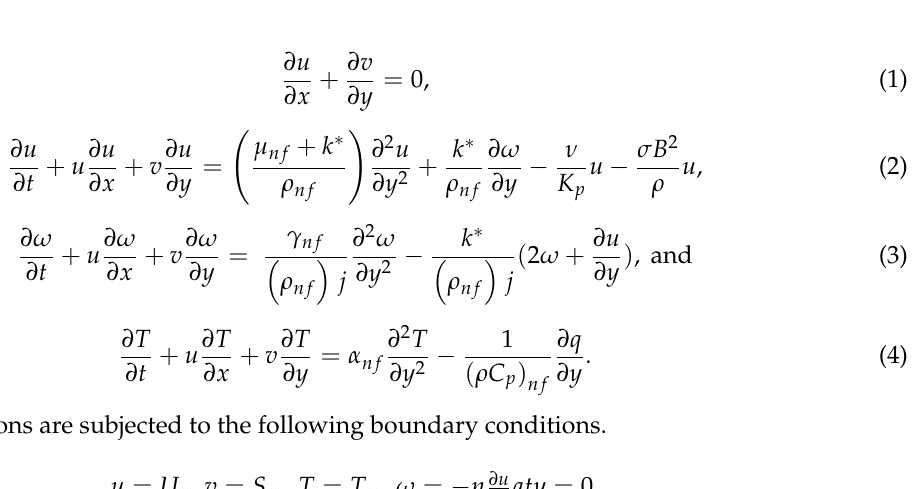
Figure 1. Physical model and coordinate